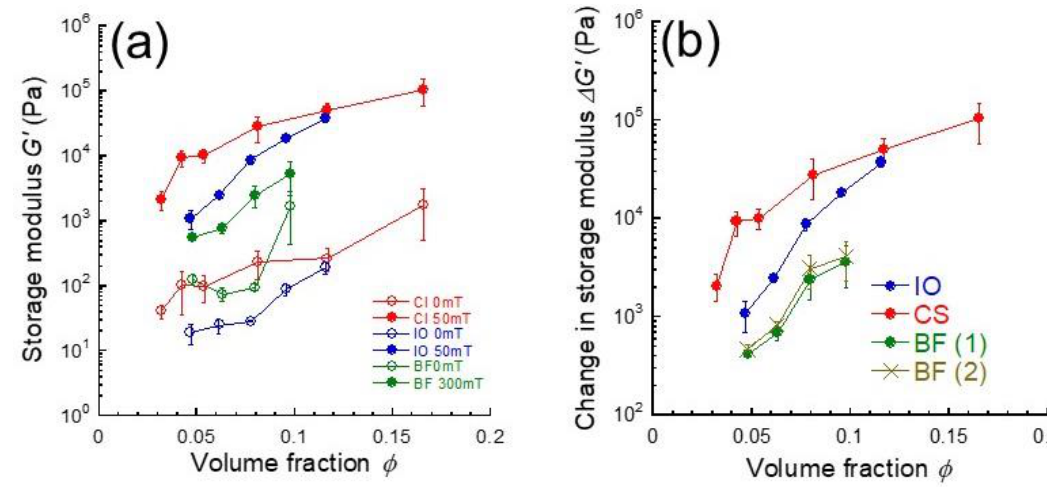
Figure 3. Volume fraction dependence of ( a ) off-field and on-field storage modulus and ( b ) change in storage modulus for carrageenan magnetic hydrogels with carbonyl iron, iron oxide, and barium ferrite particles ( γ = 10 −4 , f = 1 Hz). BF (1) and BF (2) are the change in storage modulus by the first application and second application of the magnetic field, respectively.